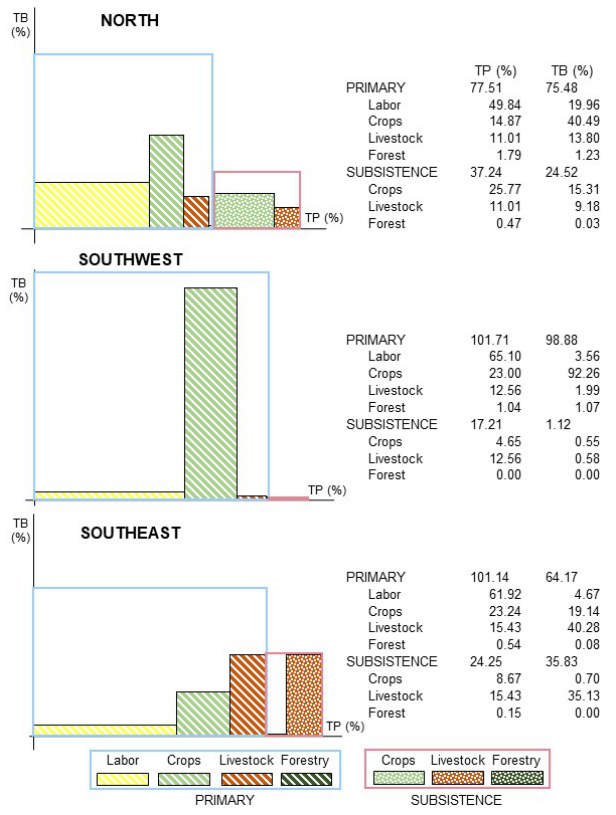
Fig. 6 . Relations between total benefits (TB) and total population (TP) for the various economic sectors within each subregion.